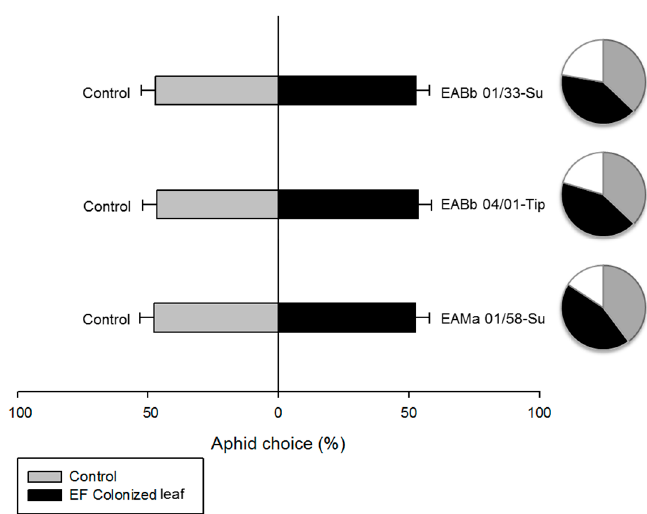
Figure 5. Percentage of Aphis gossypii adults choosing one of the two leaves offered in the choice experiment. The following choices were offered: Unsprayed leaf from a fungus-sprayed plant (i.e., endophytically colonized only); Unsprayed leaf from a control plant. Bars denote percentage of aphids choosing either the control or the endophytically-colonized leaf out of the total number of aphids making a choice. Circles denote the proportion of aphids orienting towards the unsprayed endophytically-colonized leaf (black), the unsprayed leaf from a control plant (grey) and aphids showing no decision (white).